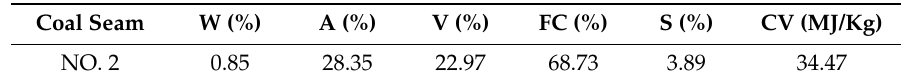
Table 2. Physical properties of the remodelled samples and test conditions.